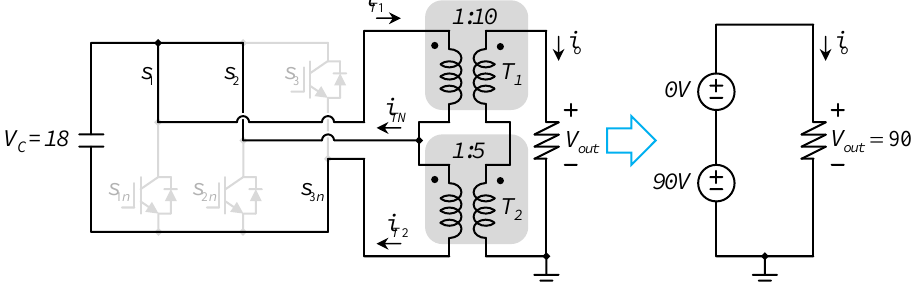
Figure 16. Equivalent circuit when s 1 = 1, s 2 = 1, and s 3 = 0 ( s 1 n = 0, s 2 n = 0, and s 3 n = 1).